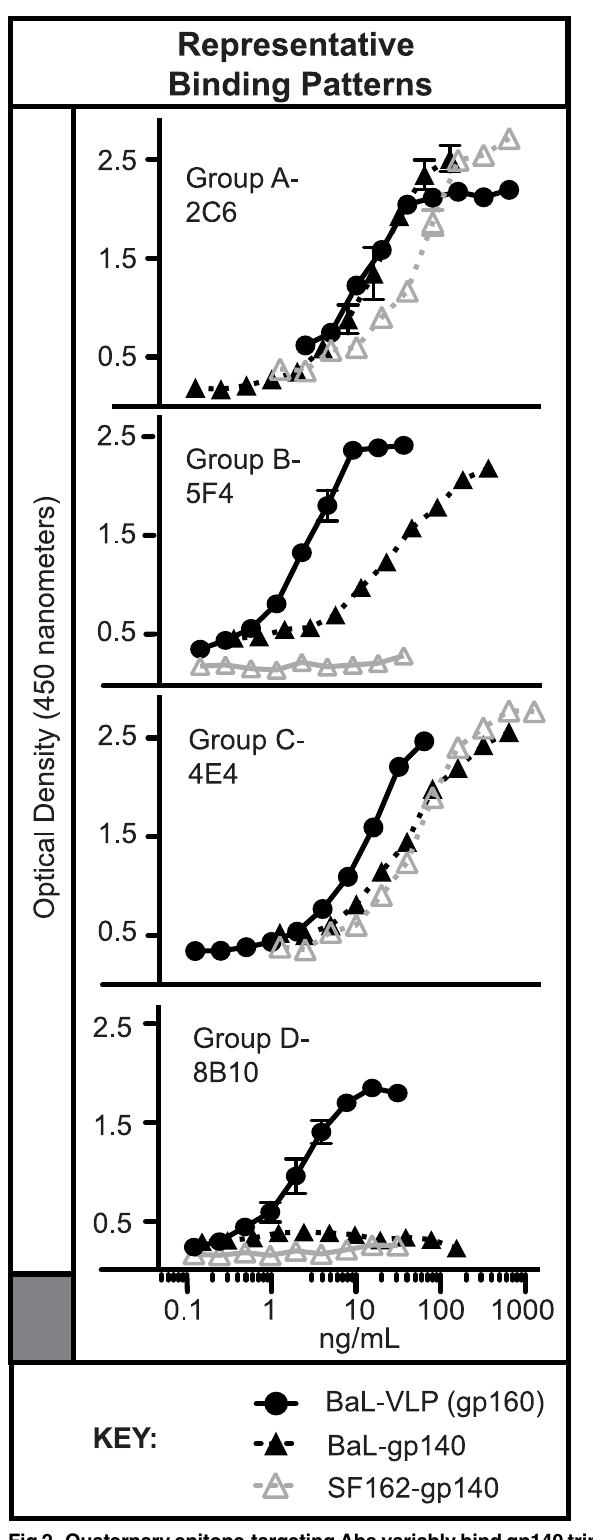
Fig 2. Quaternary epitope-targeting Abs variably bind gp140 trimers in a strain-dependent manner. Depending on the QtAb, variability was observed in binding BaL strain Env protein incorporated in